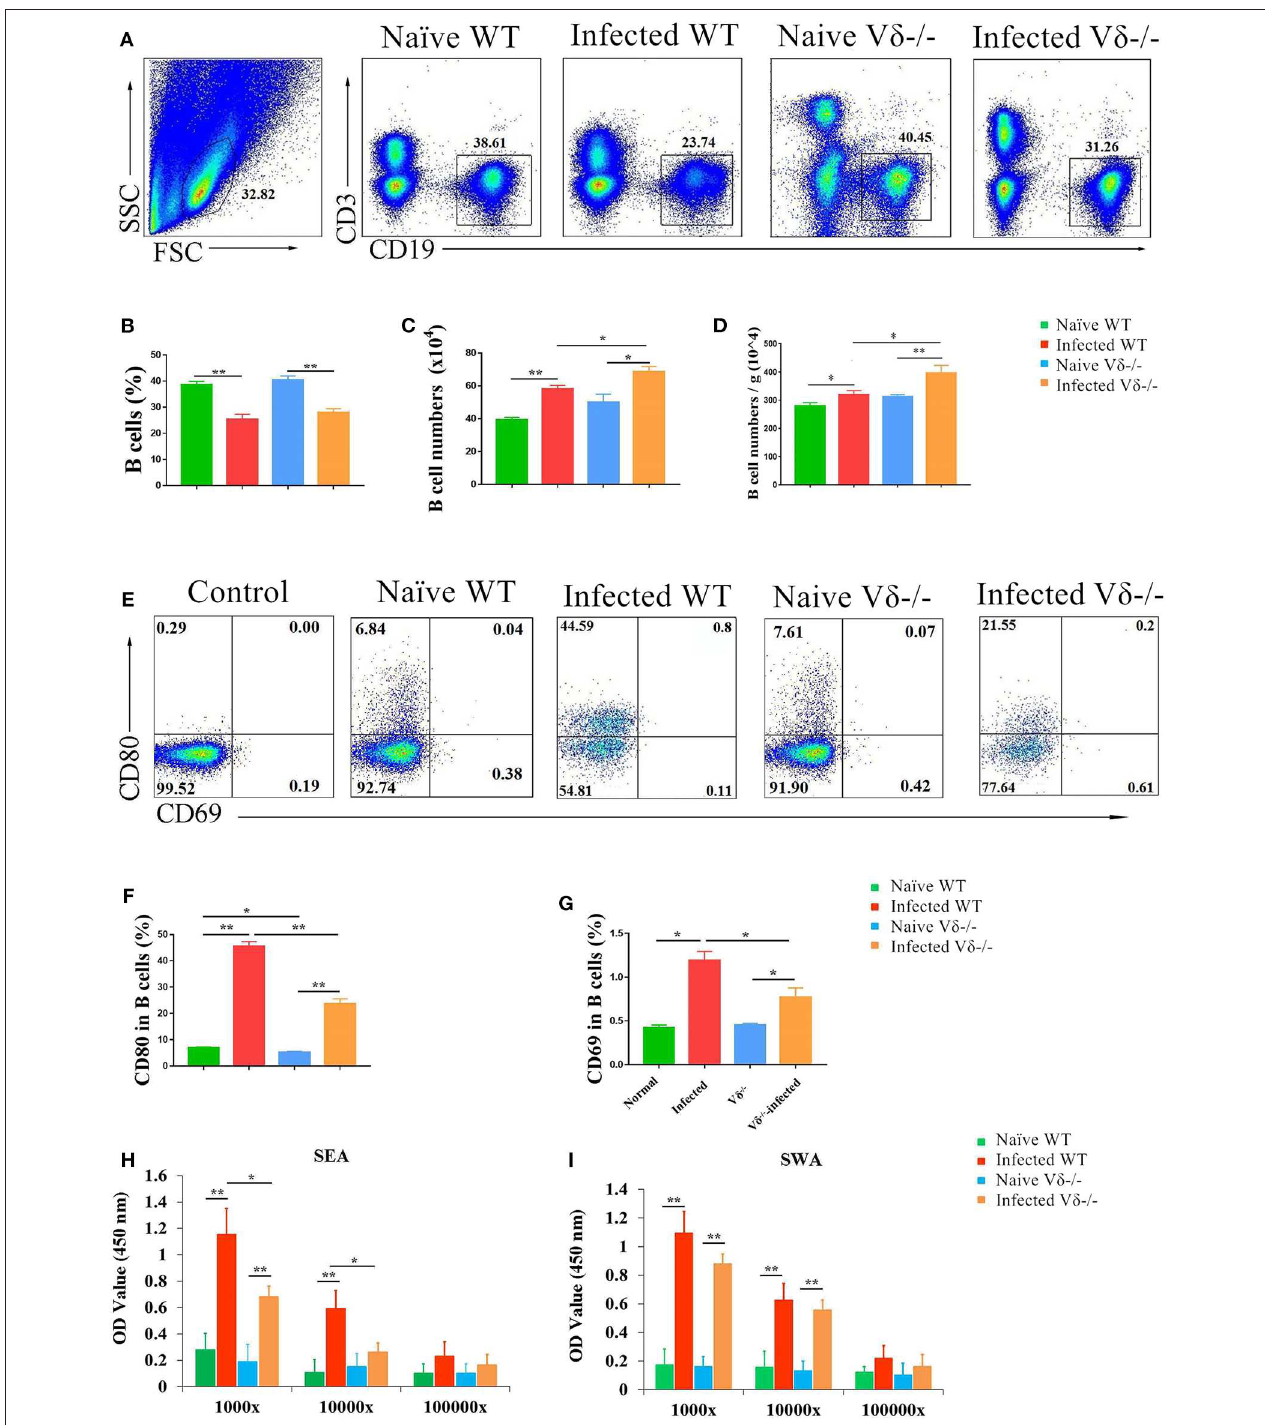
FIGURE 6 | The effect of γδ T cells on B cells. C57BL/6 mice and V δ − / − mice were infected with 40 ± 5 S. japonicum cercariae per mouse. Five to six weeks after infection, mice were euthanized. Single lung cell suspensions were separated. (A–D) Percentage and number of B cells in the lung of naïve and infected WT and V δ − / − mice were detected. (E–G) Expression of CD69 and CD80 on B cells in naïve and infected WT and V δ − / − mice. Blood were collected, and serum was diluted in different proportion (1,000, 10,000, and 100,000 folds). The levels of IgG in the serum of four groups were detected by ELISA. (H) Soluble egg antigen (SEA)-specific IgG is shown. (I) Soluble worm antigen (SWA)-specific IgG is shown. Data represent the average of three independent experiments with 5–6 mice per group. The error bars are SD, ** P < 0.01, * P < 0.05.